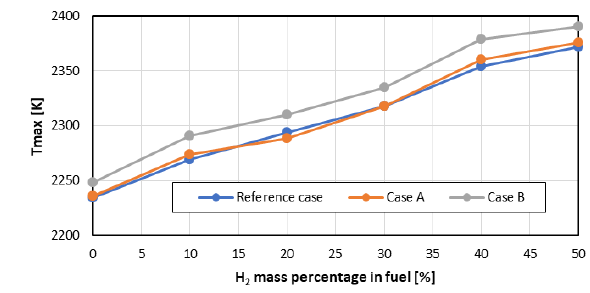
Fig. 12. Combustion maximum static temperature in combustors Firstly, it can be noticed that the maximum combustion static temperature in the reference case and that in in case A are comparable, regardless of the hydrogen mass fraction in the fuel. In case B the maximum combustion static tem- perature is higher than in the reference case and in case A.